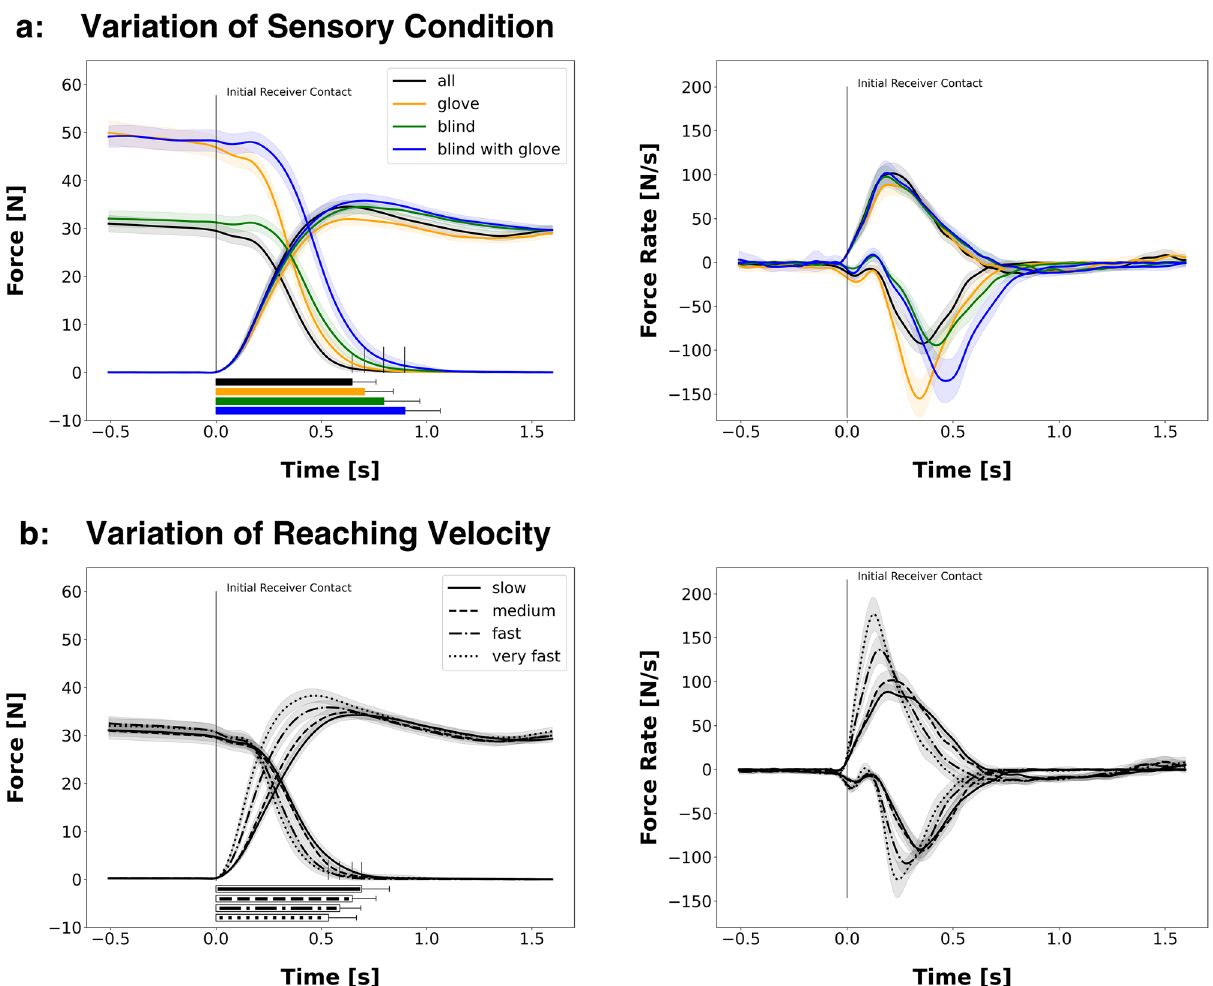
Figure 2. ( a ) Force profiles showing the effect of sensory manipulation of the passer during handover (velocity condition = medium ). Horizontal bars below illustrate the average handover duration of each condition. The right diagram shows the force rates of the passer (negative rates) and receiver (positive rates). ( b ): Force profiles of passer and receiver showing the effect of the variation of reaching velocity (sensory condition = all ). The right diagram shows the corresponding force